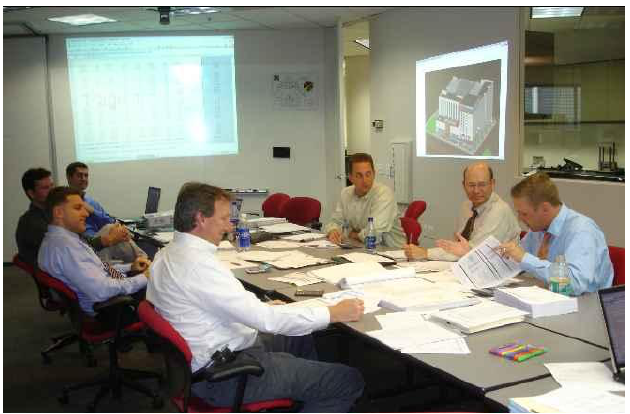
Figure 5 Trade coordination meeting using BIM in a job trailer (Courtesy of: Holder Construction Company, Atlanta,